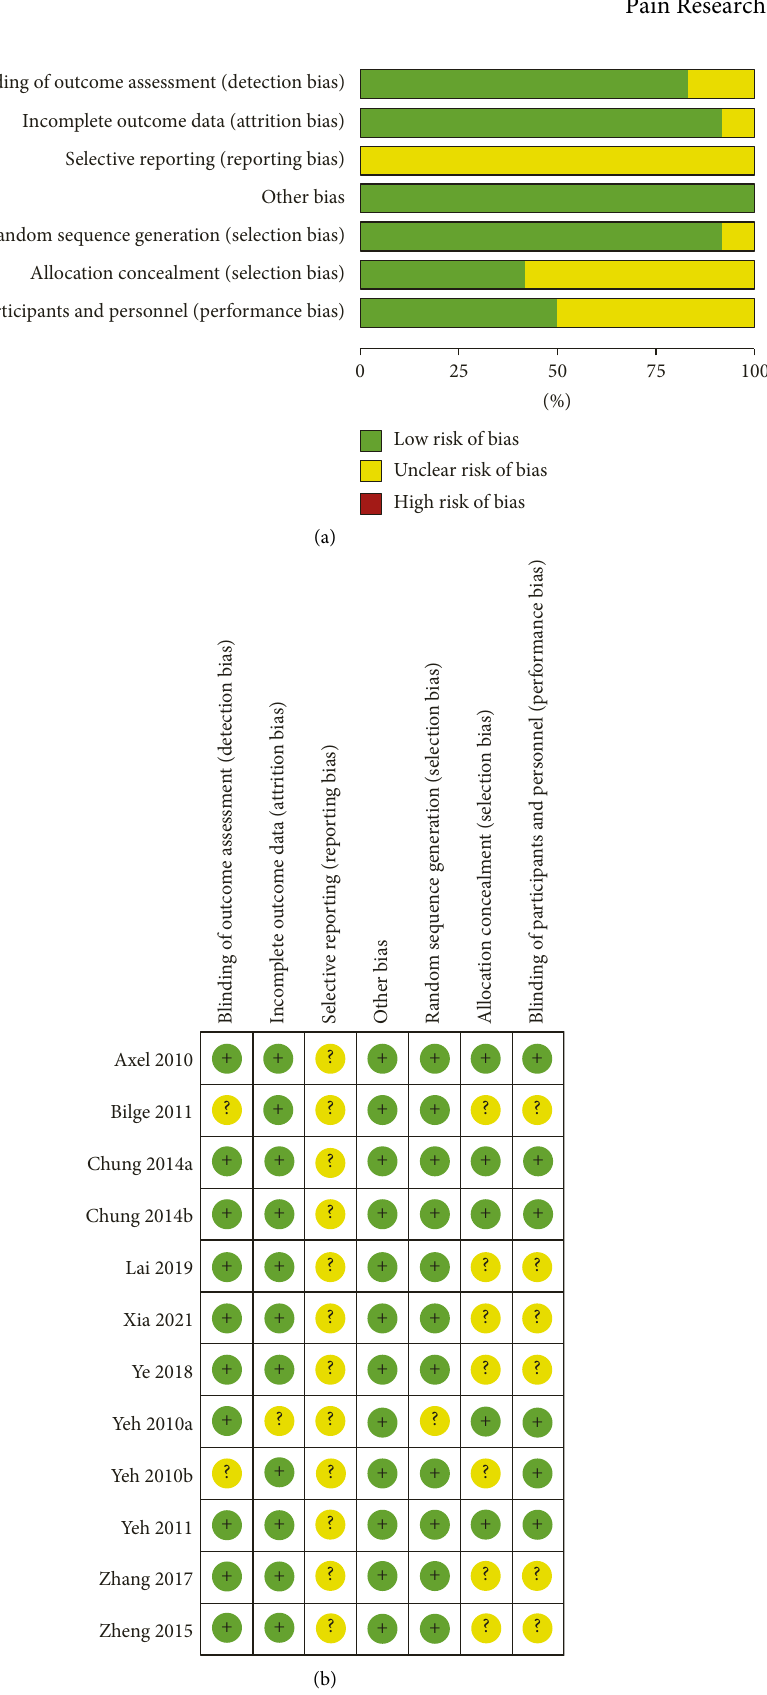
Figure 2: Risk of bias. (a) Overall quality assessment. (b) Individual quality